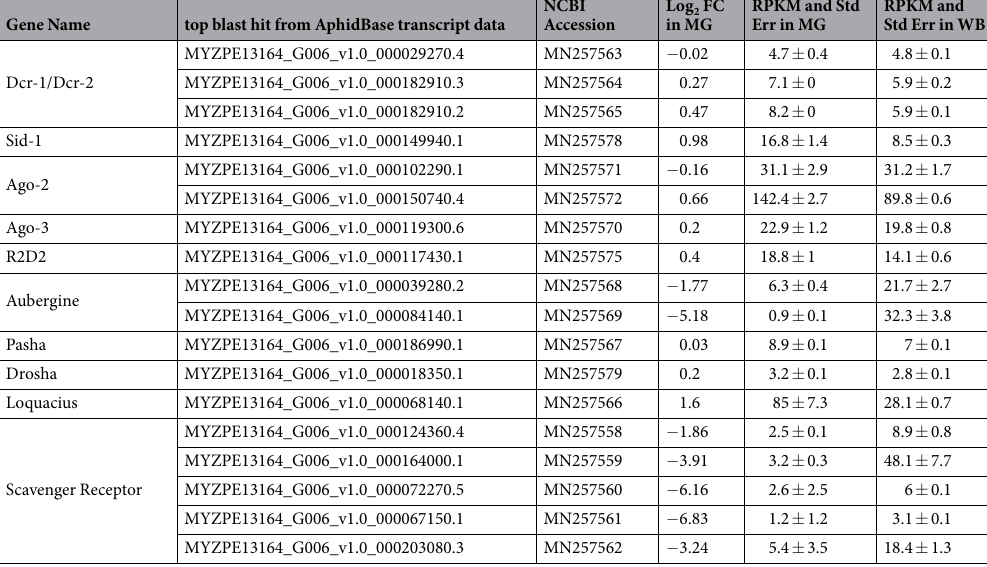
Table 1. The RNAi machinery of M . persicae . MG: Midgut. WB: Whole body, RPKM: Reads Per Kilobase of transcript per million mapped reads, Std Err: Standard Error, FC: Fold Change.